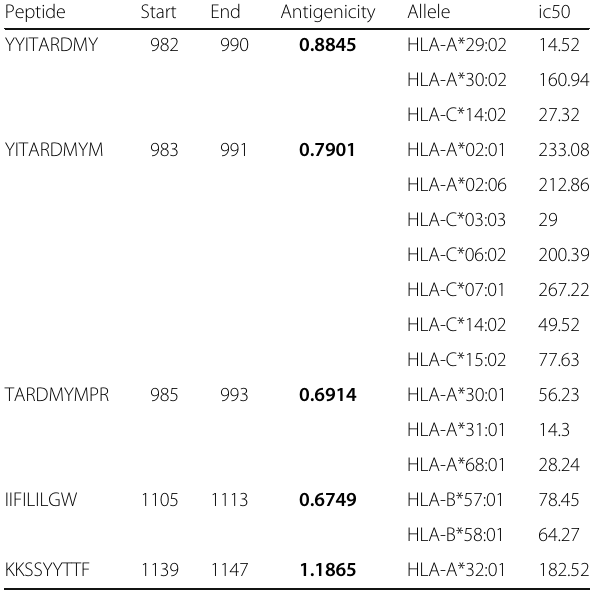
Table 6 Antigenic, non-allergic and non-toxic MHCI